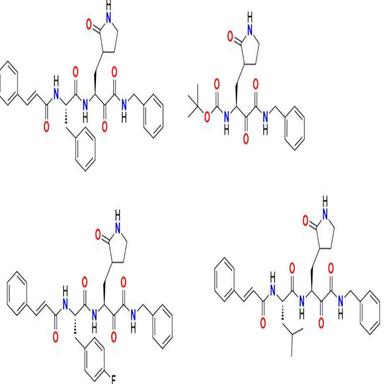
a-ketoamides used as pharmacophores as broad-spectrum inhibitors of COVID-19.